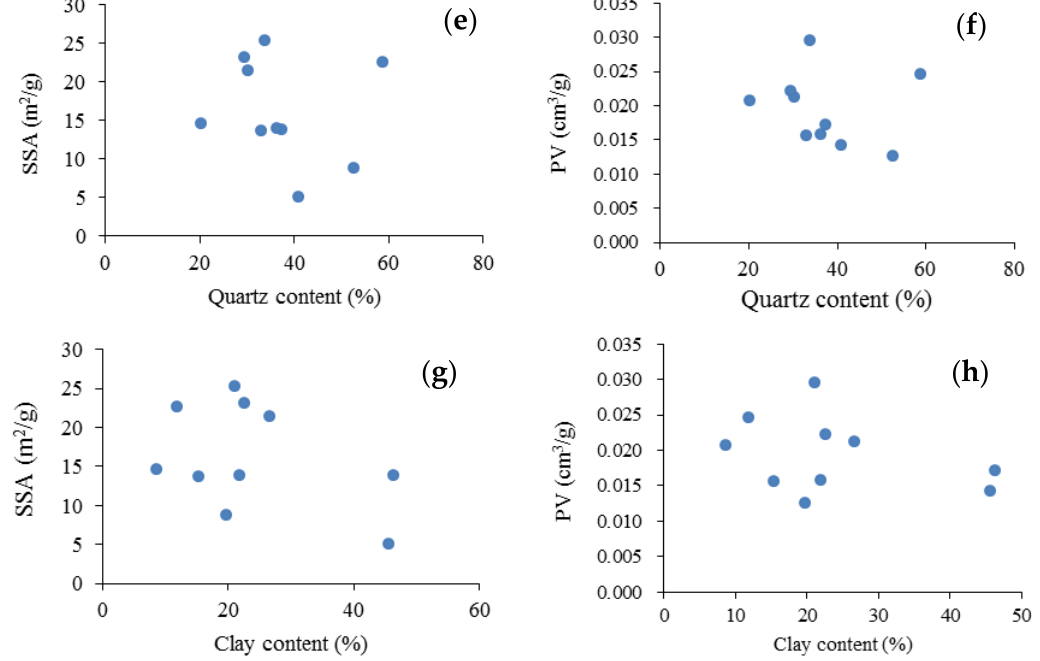
Figure 13. Relationship among structure parameters ( a , b ) and effects of shale composition on structure parameters ( c‒h ); in ( b ) and ( e‒h ), specific surface area (SSA) refers to total SSA, pore volume (PV) refers to total PV.